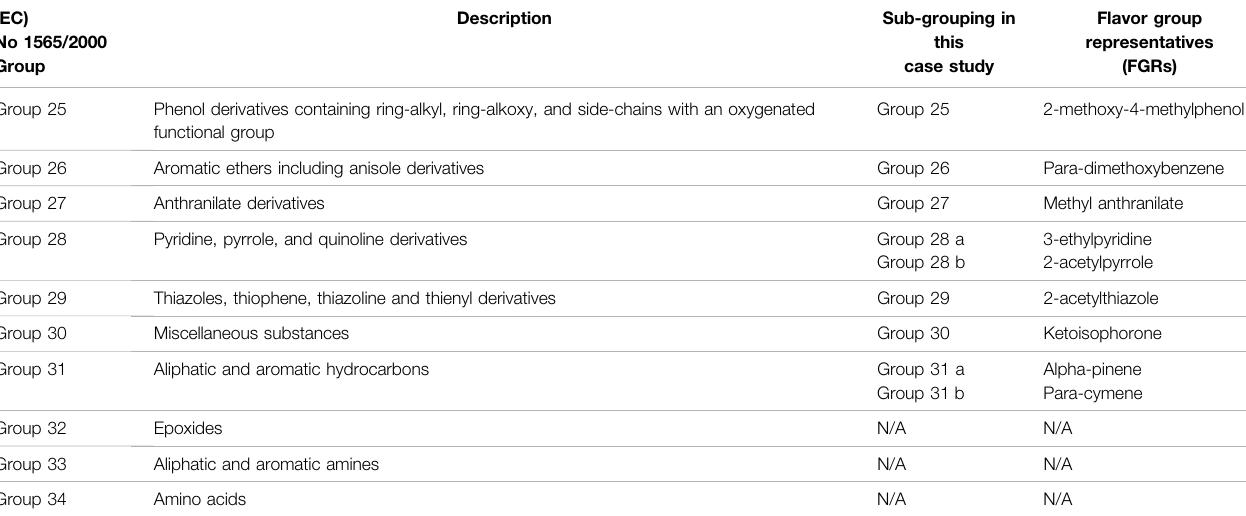
TABLE 3 | ( Continued ) Chemical groups for fl avor ingredients de fi ned inthe commission regulation (EC) No1565/2000 and further subclustering and selected FGRs for this case